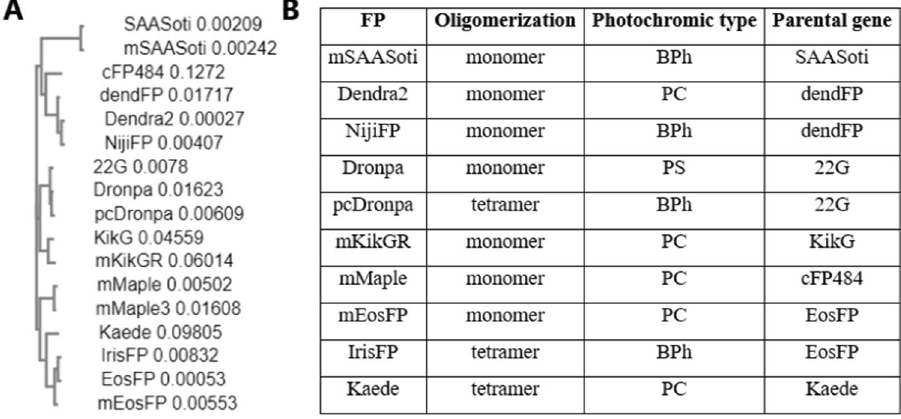
Figure 1. ( A ) Bayesian phylogenetic tree of the biphotochromic proteins and their ancestors. Numbers on the right represent branch lengths. (Data obtained with Clustal Omega tool https:// www. ebi. ac. uk/ Tools/ servi ces/ rest/ clust alo 33 ). ( B ) Photochromic properties, oligomerization state and parental gene. BPh biphotochromic protein, PC photoconvertible protein, PS photoswitchable protein.